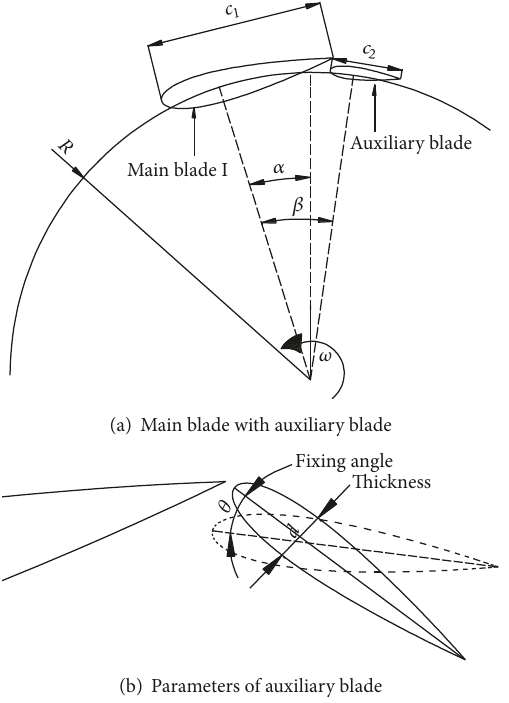
Figure 1: SB-VAWT with auxiliary